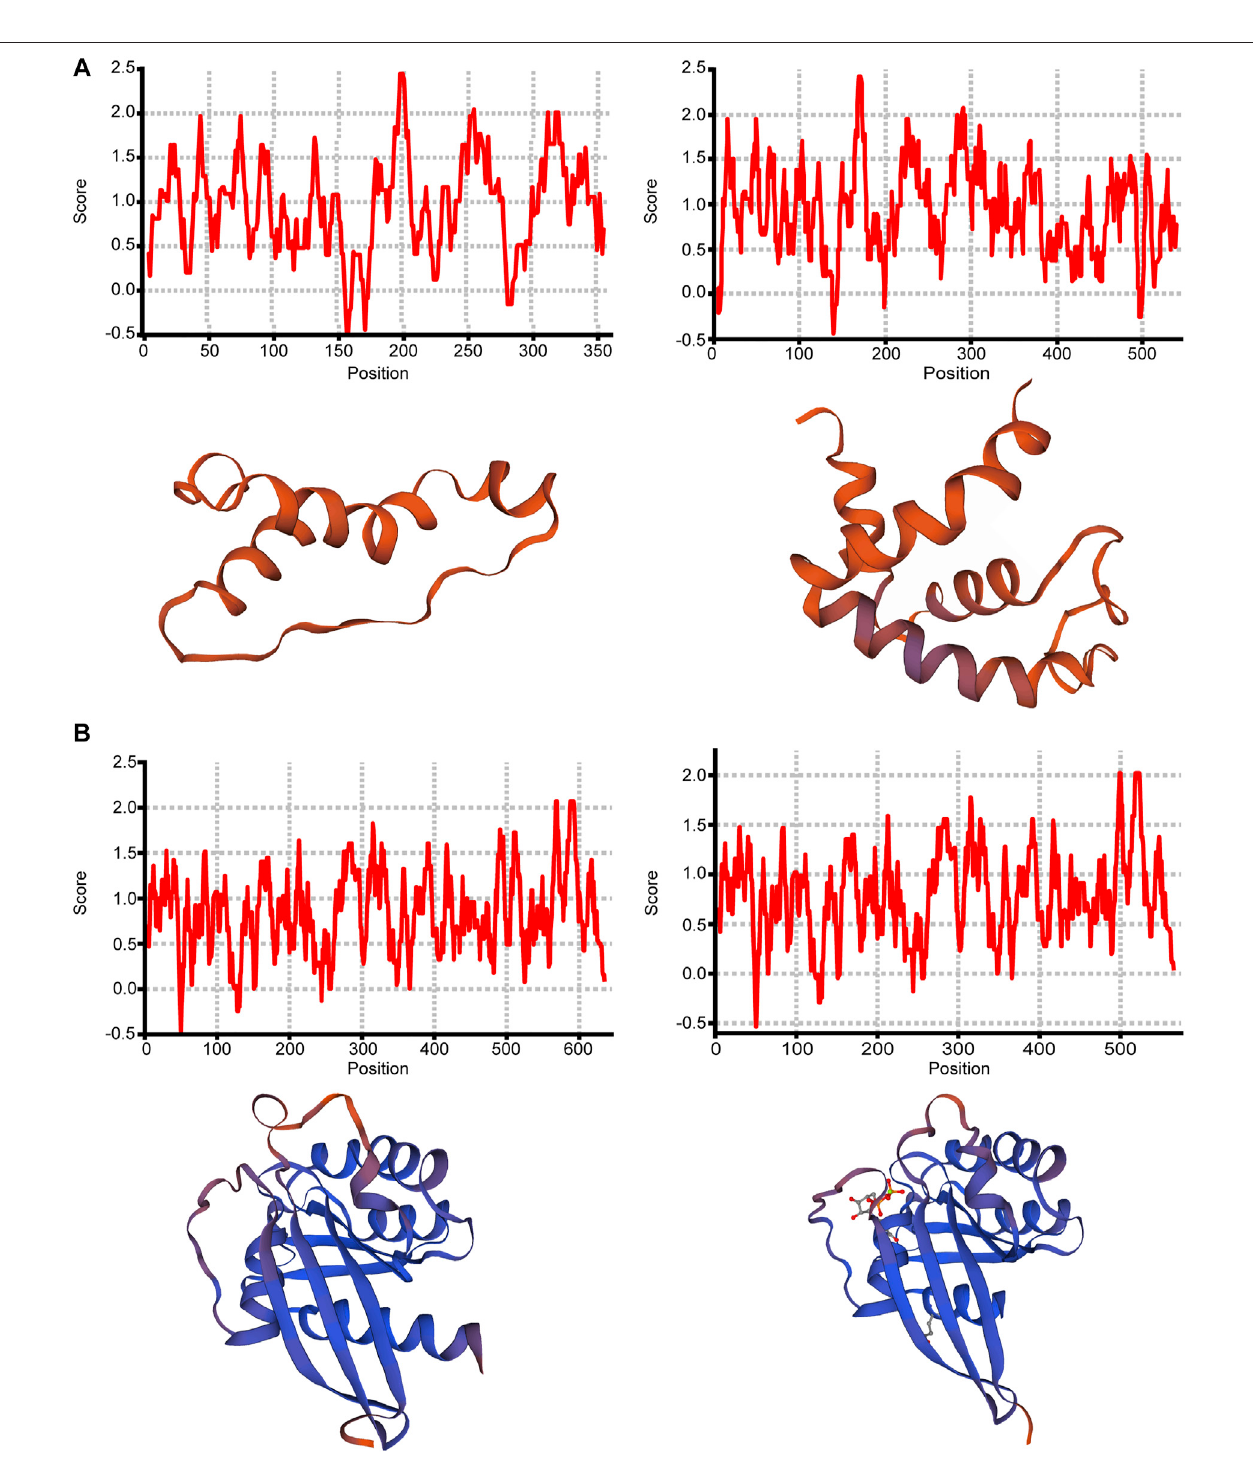
FIGURE 5 | Protein structure analysis of ONT.15153.1, ONT.15153.3, ONT.10349.2 and ONT.10349.9. (A) Protein hydrophobicity analysis and protein tertiary structure analysis of ONT.15153.1 and ONT.15153.3; (B) Protein hydrophobicity analysis and protein tertiary structure analysis of ONT.10349.2 and ONT.10349.9.